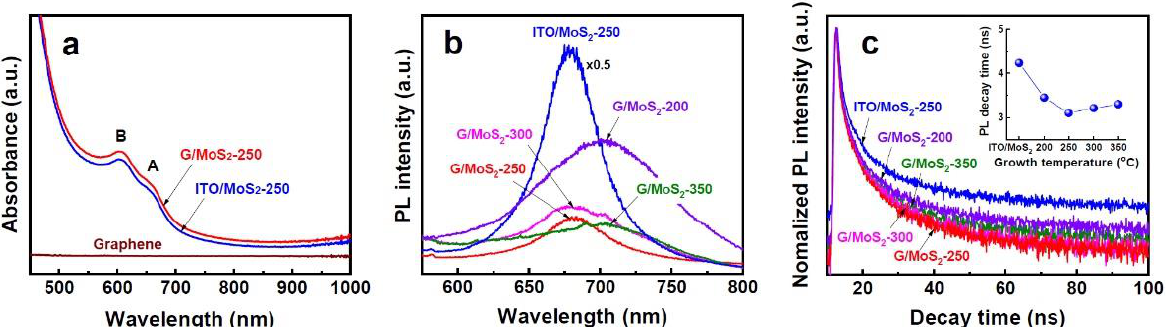
Figure 5. ( a ) UV–Vis absorption spectra of ITO/MoS 2 -250, G/MoS 2 -250, and pristine graphene. ( b ) PL spectra and ( c ) TRPL results of ITO/MoS 2 -250, G/MoS 2 -200, G/MoS 2 -250, G/MoS 2 -300, and G/MoS 2 -350. The inset in ( c ) shows the carrier lifetimes extracted from corresponding TRPL meas- urements.